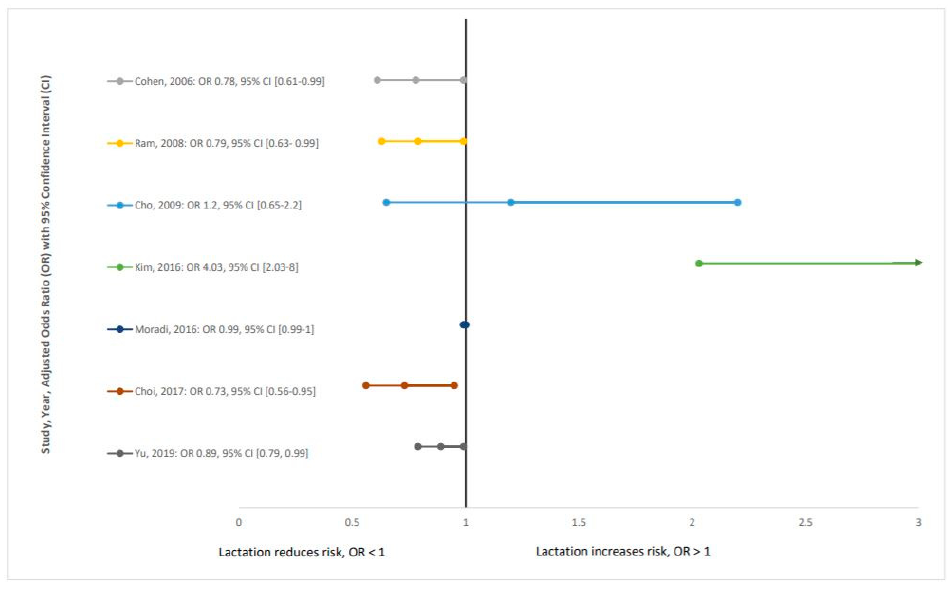
Figure 2. Adjusted odds ration with 95% confidence intervals across studies.